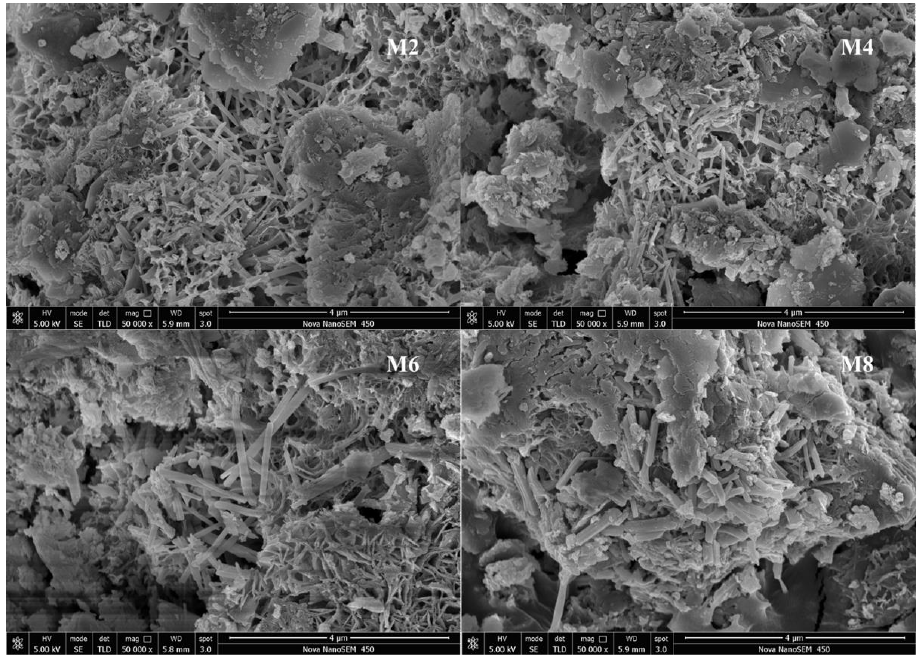
Figure 7. SEM images of SAR specimens at 28 days.